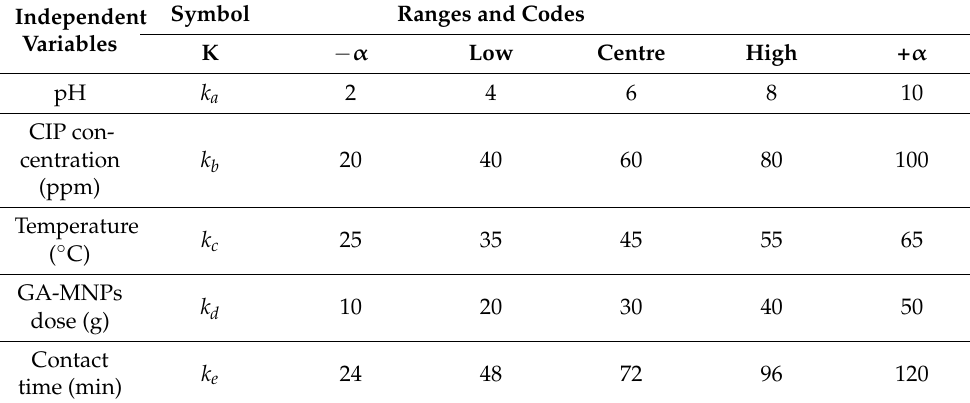
Table 2. RSM matrix for the optimization of CIP removal.